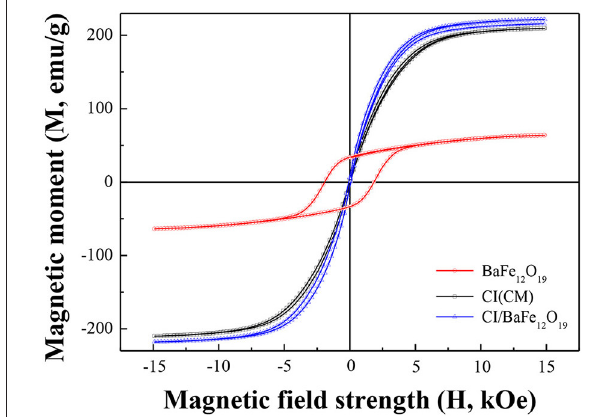
FIGURE 2 | Vibrating sample magnetometer data of pure carbonyl iron (CI) (CM grade), BaFe 12 O 19 , and CI/BaFe 12 O 19 0.5 wt% mixture.